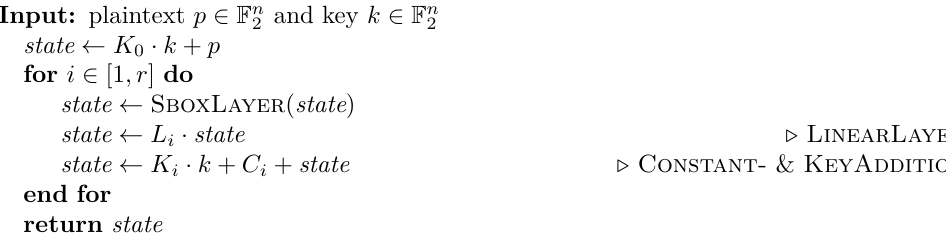
Algorithm 1 LowMC encryption. Parameters: key matrices K i ∈ F n × n